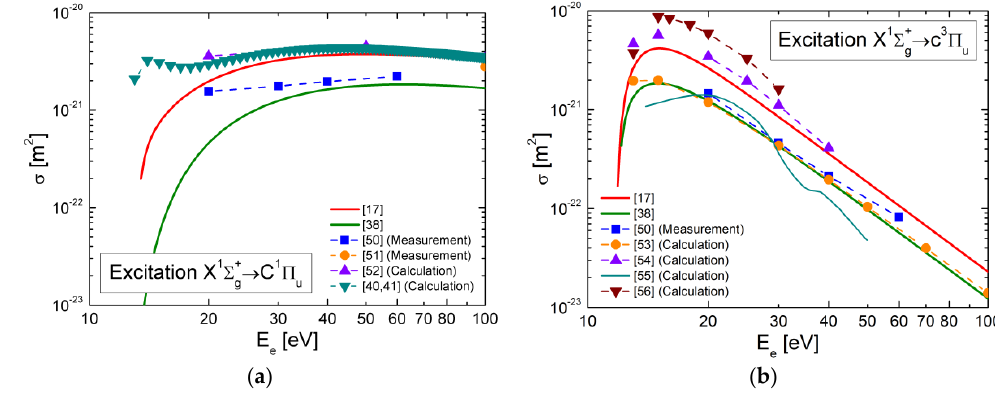
Figure 8. Electron collision excitation cross-sections from the literature for molecular hydrogen: ( a ) excitation from the ground state X 1 to the excited state C 1 in the singlet system; ( b ) excitation from the ground state X 1 to the excited state c 3 in the triplet system.